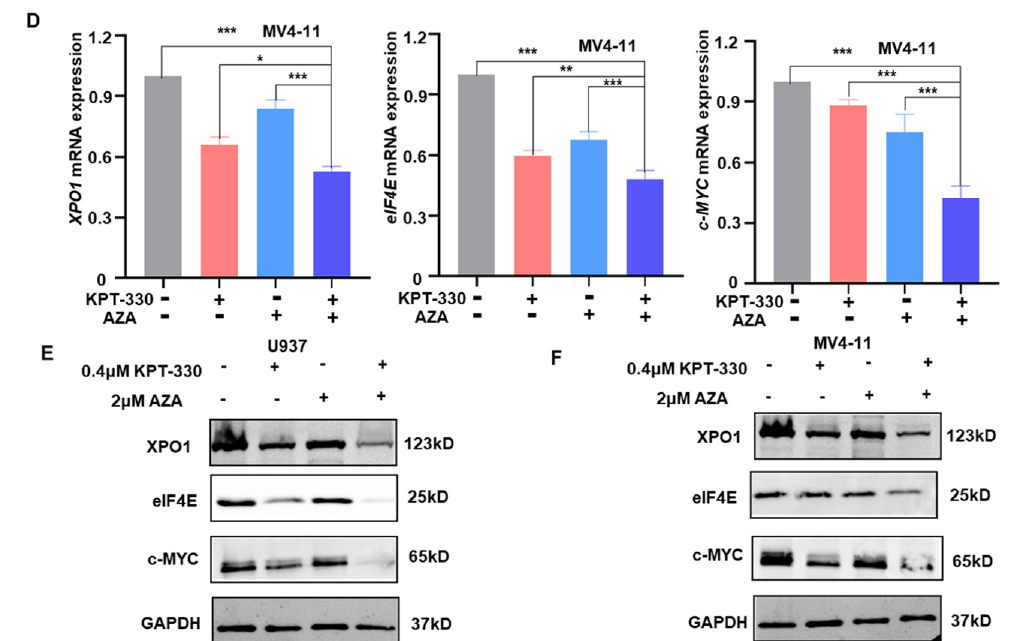
Figure 3. Transcriptome analysis to identify the key genes and pathways responsible for the synergis- tic effect. ( A ) RNA-seq data volcano graph; Red represents up-regulated genes and green represents down-regulated genes. ( B ) GSEA analysis graph. ( C , D ) qPCR data to show the changes of the key genes ( XPO1 , elF4E , and c-MYC ) in U937 and MV4-11 cells upon the treatment (DMSO, KPT-330, AZA, and combo). ( E , F ) Western blot data to show the changes of the key genes (XPO1, elF4E, and c-MYC) in U937 and MV4-11 upon the treatment (DMSO, KPT-330, AZA, and combo). * p < 0.05, ** p < 0.01, *** p <